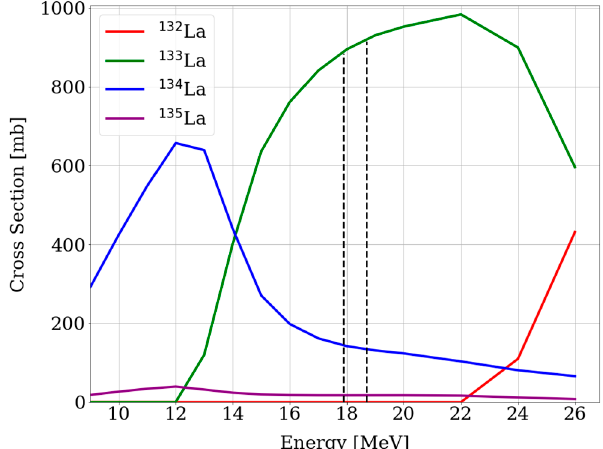
Figure 1. Calculated cross sections of relevant nuclear reactions using TENDL-2019, leading to La radioisotopes via the 134 Ba(p,xn) route weighted for the [ 134 Ba]BaCO 3 enriched target. The dotted lines indicate the energy range used in this work.